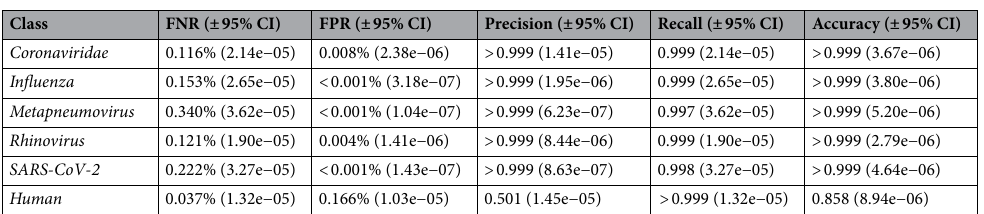
Table 1. Average of performance metrics for each class in 100 independent simulated datasets. CI confidence interval, FPR False positive rate, FNR False negative